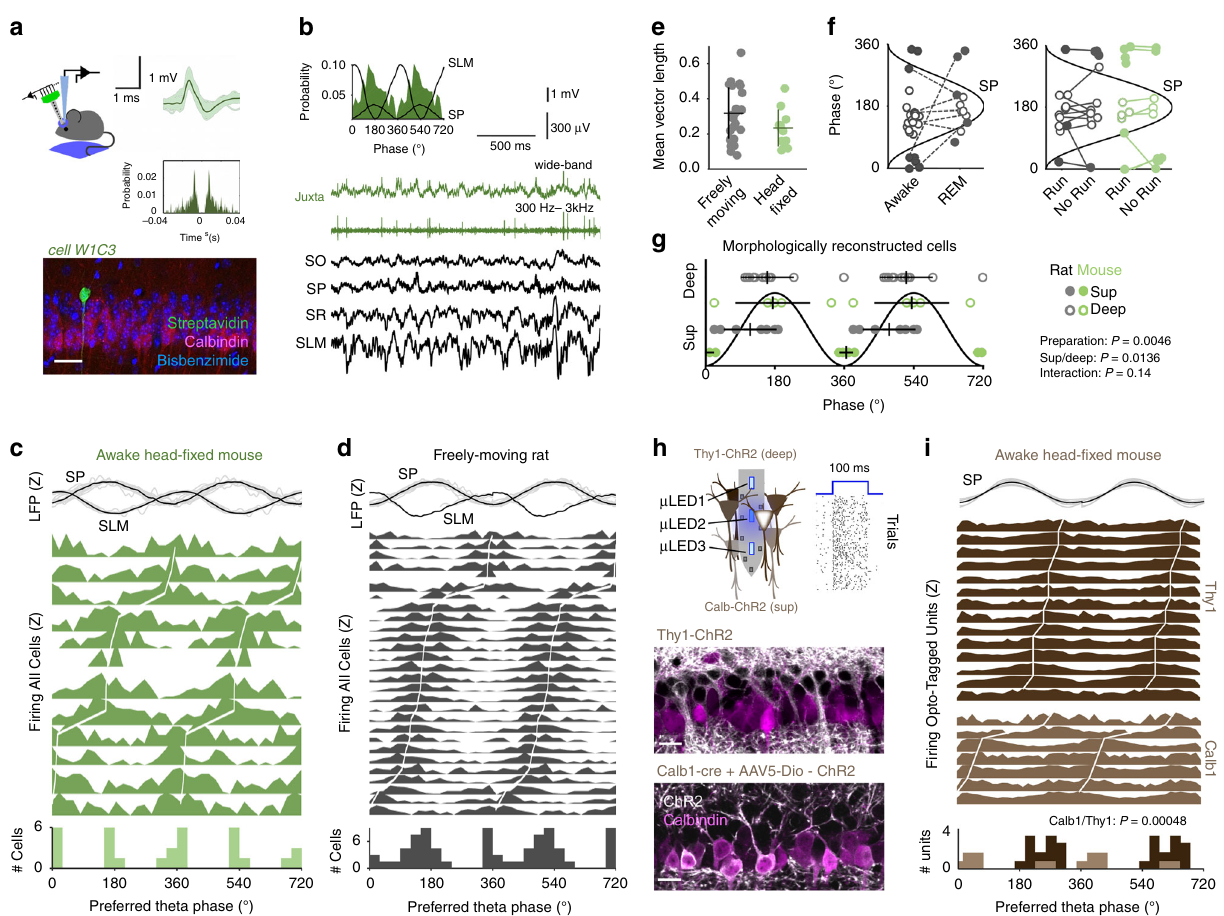
Fig. 1 Bimodal distribution of theta phase-locked fi ring across CA1 sublayers. a Representative example of a CA1 pyramidal cell recorded juxtacellularly from a head- fi xed running mouse. See average action potential waveform and autocorrelation at right, and morphological identi fi cation as deep cell at bottom. Scale bar 50 µ m. b Theta phase-locked fi ring histogram of the cell shown in a . Raw local fi eld potential (LFP) traces and juxtacellular signals are shown below: SO, stratum oriens; SP, stratum pyramidale; SR, stratum radiatum; SLM, stratum lacunosum moleculare. c Theta phase fi ring histogram from single cells recorded in awake head- fi xed mice, ranked according to their preferred phase ( n = 12 cells). Individual (gray) and mean (black) theta fi ltered LFP signals at top are z -scored ( Z ). The population histogram at bottom represents the distribution of mean preferred phases from individual cells. d Same for single pyramidal cells recorded juxtacellularly in freely moving rats ( n = 28 cells). e Individual and mean ± SD values of vector length per cells reported before in head- fi xed and freely moving conditions. No differences between groups. f Awake/REM sleep (left) and RUN/no-RUN (running vs. other motor behavior) dependency of theta phase preference of single pyramidal cells. See legend in ( g ). g Multivariate analysis of morphologically identi fi ed cells demonstrate effects per location (Harrison – Kanji test for deep-super fi cial location: χ 2 (2) = 10.7, p = 0.0136) and preparation ( χ 2 (2) = 8.5, p = 0.0046); no interaction ( χ 2 (1) = 2.1, p = 0.148). Phase preferred data from each morphologically identi fi ed cell is depicted separately for deep and super fi cial cells in both preparations. h Optogenetic tagging of single units using micro-LED optoelectrodes in two transgenic lines allowed identifying super fi cial (Calb1-cre + AAV5-DIO-ChR2-YFP) and deep CA1 pyramidal cells (Thy1-ChR2). Raster at right shows response of one representative unit to 79 trials of nanowatt blue light stimulation in a Thy1-ChR2 mouse. Bottom, ChR2 signal (white) and Calbindin immunostaining (magenta) are shown in false colors (one confocal plane from each line). Scale bar 25 µ m. i Phase-locked fi ring histograms from Calbindin + super fi cial ( n = 7 units from 3 mice) and Thy1 + deep opto-tagged units ( n = 14 units from 2 mice; statistically different Watson – Williams test, F(1,20) = 17.7, p = 0.00048. Note that bimodal distribution of preferred theta phases can be explained by different cell-type contribution.